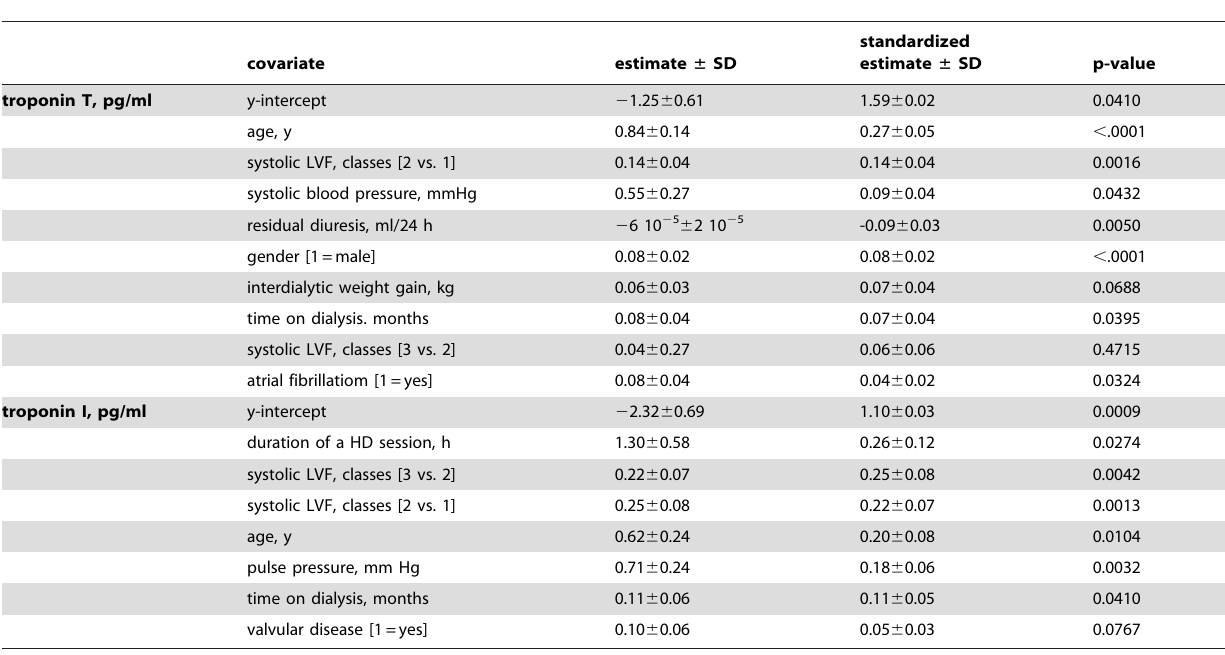
Table 3. Independent factors determining plasma troponin concentrations by multivariate linear modeling (n =201).